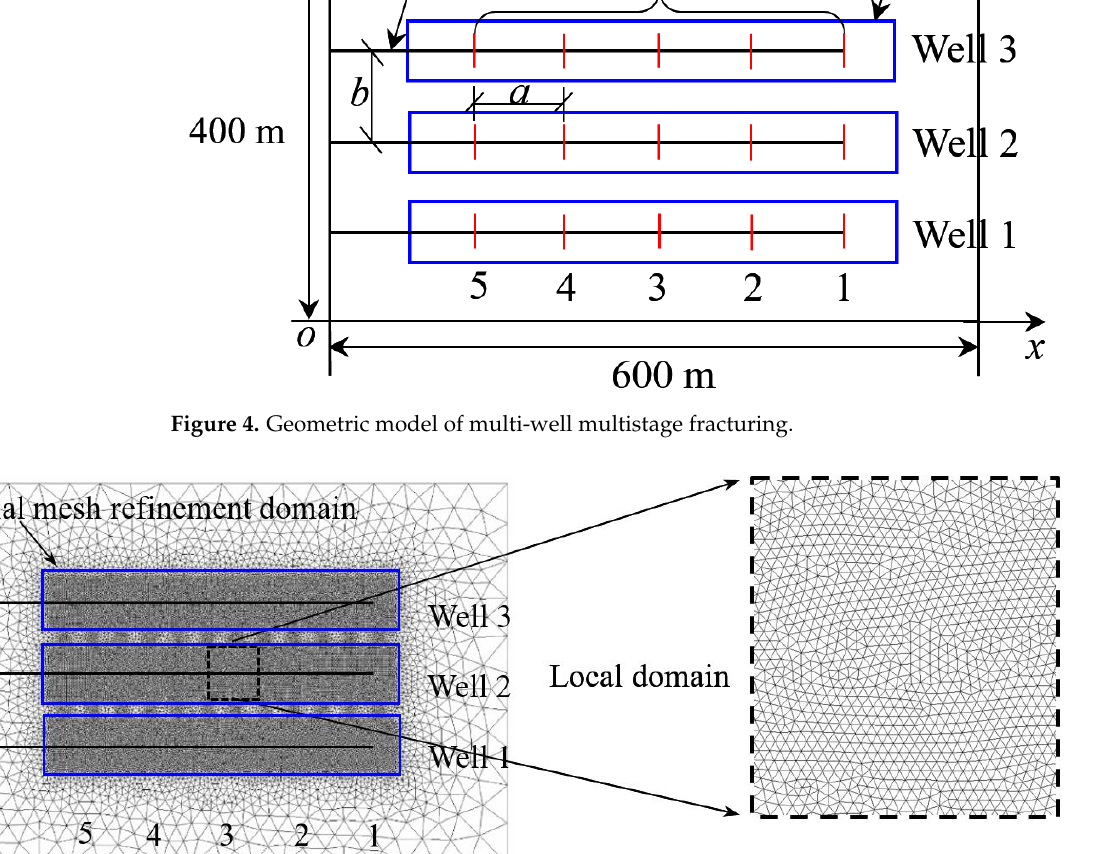
Table 2. Basic physical parameters of the numerical model. Parameters